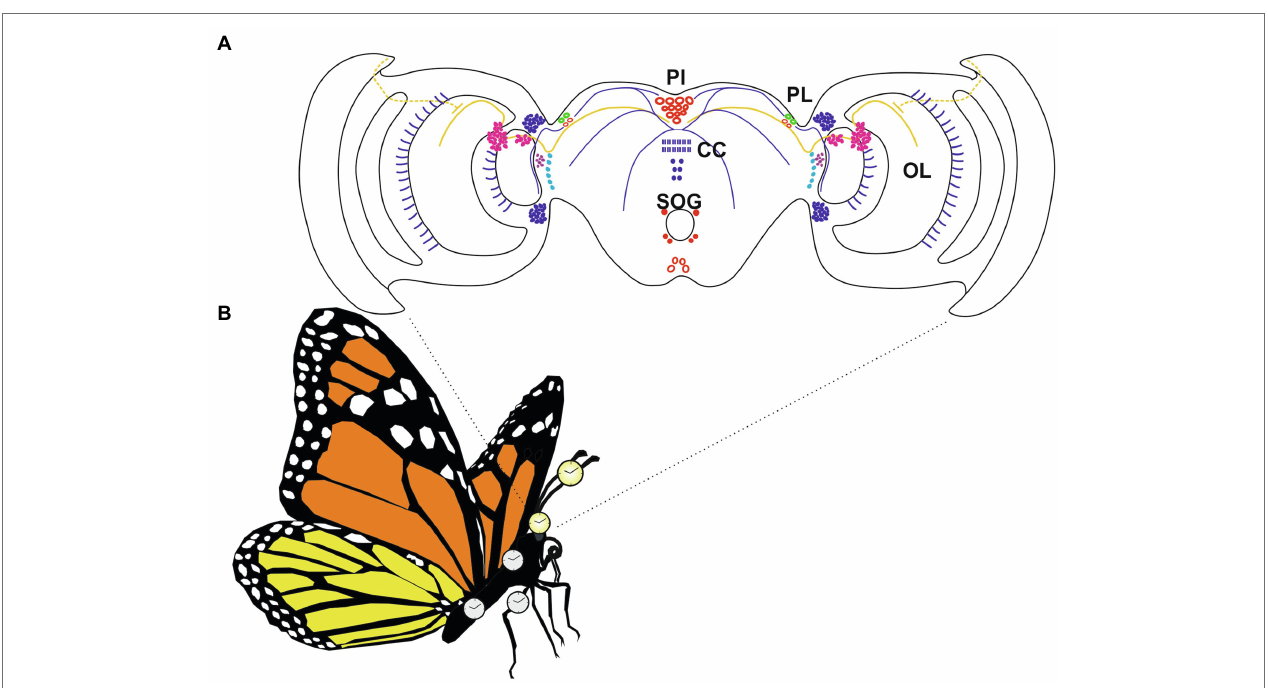
FIGURE 3 | The circadian system in Danaus plexippus adults, with multiple oscillators located in the brain and body. (A) Relative positions of neurons and fibers expressing clock factors in D. plexippus brain. In each brain hemisphere, two Pars Lateralis (PL; green) neurons co-express DpTIM, DpPER, DpCRY1, and DpCRY2. These PL cells are believed the putative circadian clock neurons of the D. plexippus brain. Neurons expressing DpTIM, DpPER, DpCRY1, and/or DpCRY2 are depicted in red. In these cells, the four clock molecules partially colocalize. Regions expressing DpTIM or DpCRY1 are indicated in magenta. In these areas, TIM and CRY1 do not colocalize. Cells exclusively expressing TIM or PER are represented in purple and light blue, respectively. CRY2-positive neurons and fibers are shown in blue. Continuous yellow lines indicate fibers expressing CRY1. Dotted yellow lines indicate projections of the dorsal rim area. PL, Pars lateralis; PI, Pars intercerebralis; CC, central body; SOG, Subesophageal ganglion; and OL, optic lobe (modified from Sandrelli et al., 2008; see text for explanation). (B) Schematic representation of an adult monarch butterfly. Yellow clocks represented autonomous oscillators located in the brain and antennae (Sauman et al., 2005; Zhu et al., 2008; Merlin et al., 2009). White clocks indicate monarch butterfly tissues (thorax, legs, and abdomen) which showed a rhythmic expression of different clock factors in LD conditions (Merlin et al., 2009) and are likely sites of peripheral